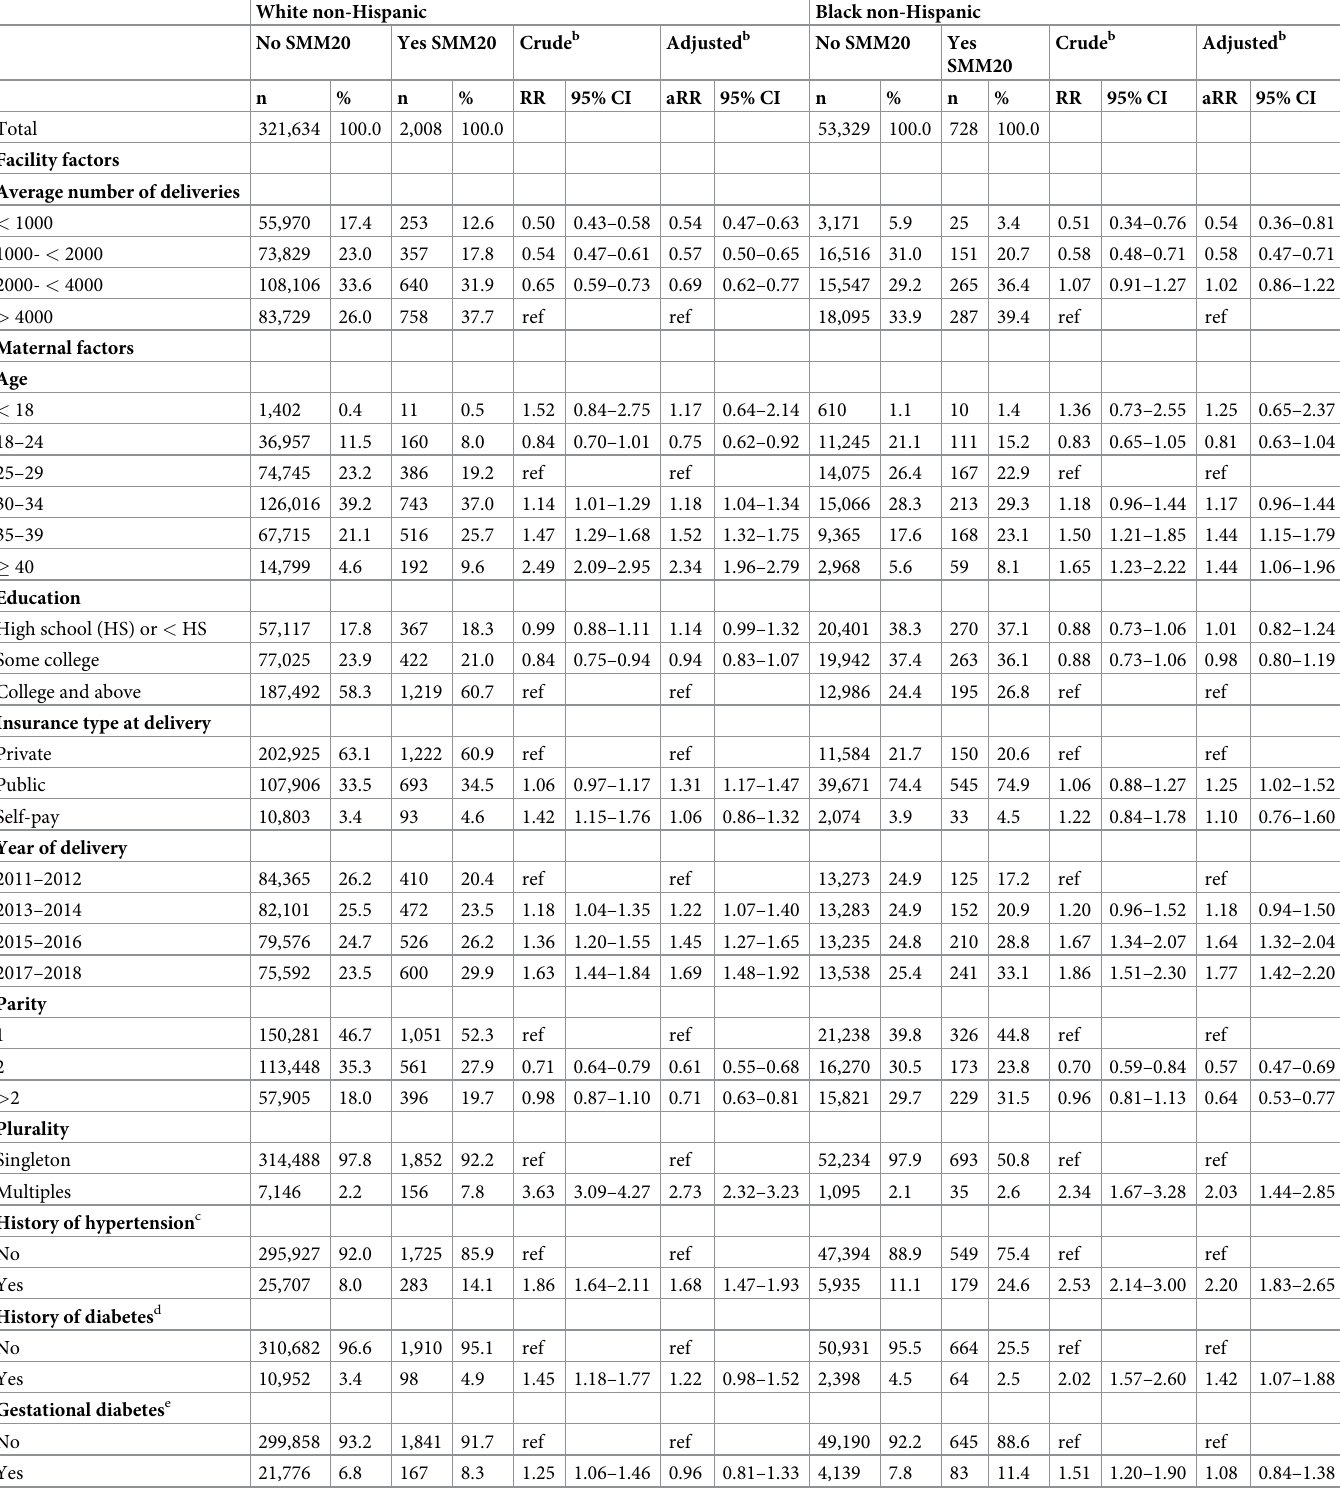
Table 3. Characteristics associated with severe maternal morbidity a including body mass index for White non-Hispanic and Black non-Hispanic birthing people: Massachusetts February 1, 2011-December 31, 2018. White